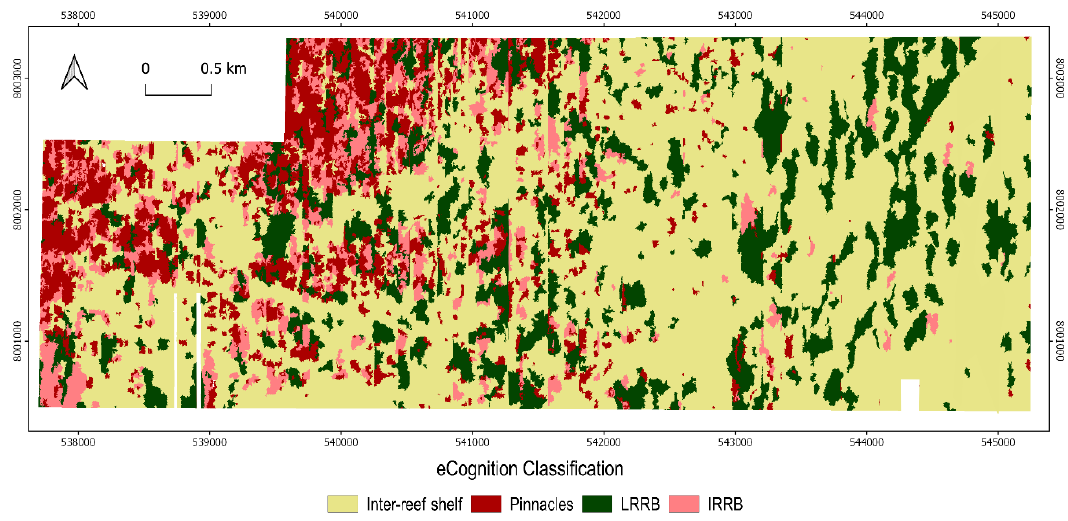
Figure 6. Supervised SSS data segmentation.